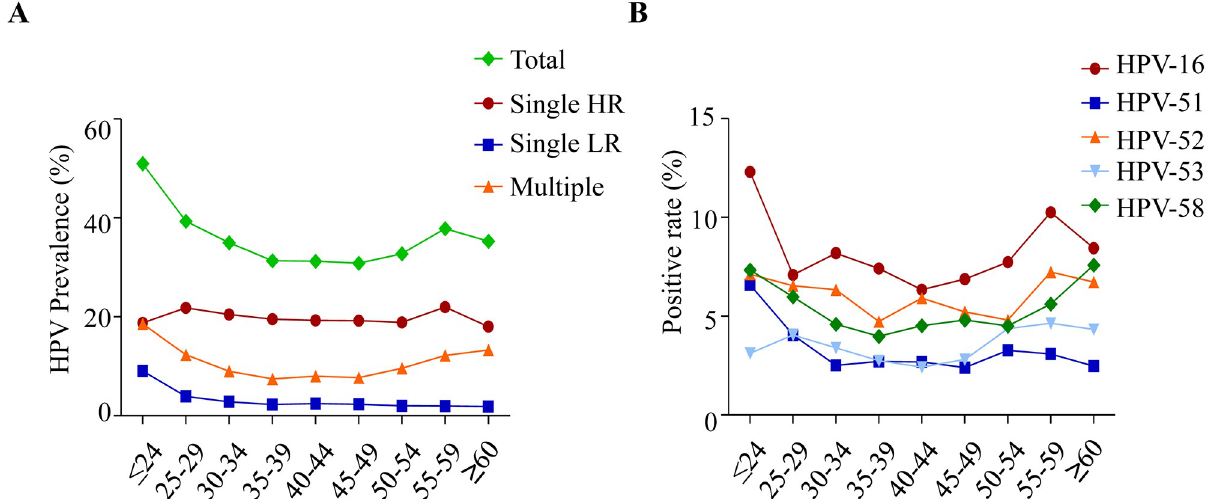
Fig 1. Overall age-related HPV prevalence among women. (A) The prevalence of total HPV, single HR-HPV, single LR-HPV and multiple HPV infections according to age. (B) The prevalence of the age-related 5 most prevalent genotypes HPV16, 51, 52, 53 and 58.